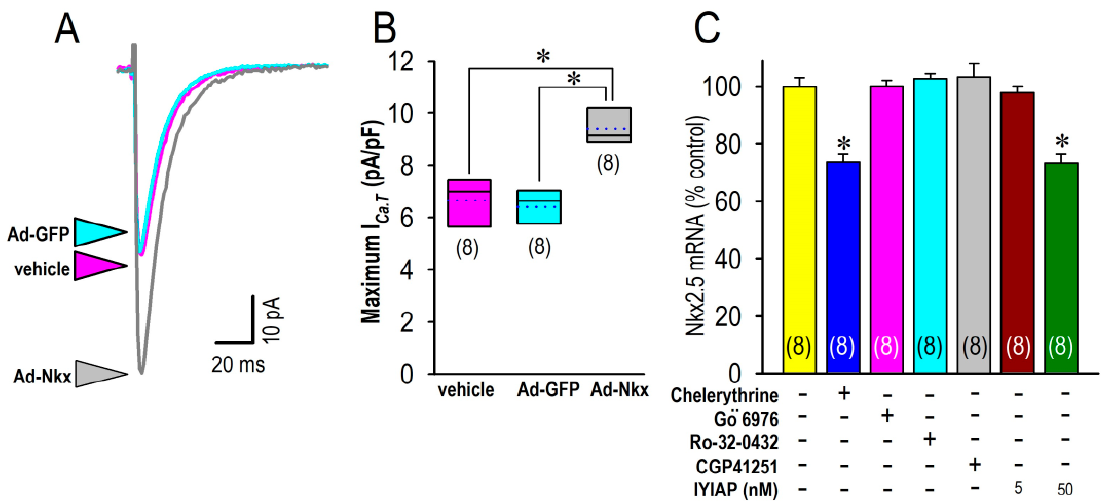
Figure 8. Actions of a transcription factor, Nkx2.5, on I Ca.T associated with PKC activity. ( A ) Repre- sentative current traces of I Ca.T at 0 mV from myocyte treated in vehicle (magenta arrowhead), Ad-GFP-treated (blue arrowhead) or Ad-Nkx treated myocytes (gray arrowhead) 24 h after infection of each recombinant adenovirus. ( B ) Group data for the maximum I Ca.T obtained at -20 mV in myo- cytes treated in vehicle (magenta), Ad-GFP (blue), or Ad-Nkx (gray). Data were expressed as mean (solid line) ± S.D. (height of the box) with the median (dotted line). ( C ) Expression of Nkx2.5 mRNA assessed by real-time PCR in myocytes isolated at day 2 treated in vehicle (yellow); 2 μ M chel- erythrine (navy); a PKC α inhibitor Gö 6976 of 20 nM (magenta); a PKC α inhibitor Ro-32-0432 of 30 nM (blue); a PKC β I inhibitor CGP41251 of 2 μ M (gray); a PKC β I inhibitor IYIAP at 5 nM (brown); or a PKC β II inhibitor of IYIAP at 50 nM (green) applied for 24 h. Amount of each mRNA was normal- ized to the mean in vehicle (yellow) as assigned as 100. Data were expressed as mean ± S.E. (n = 8).